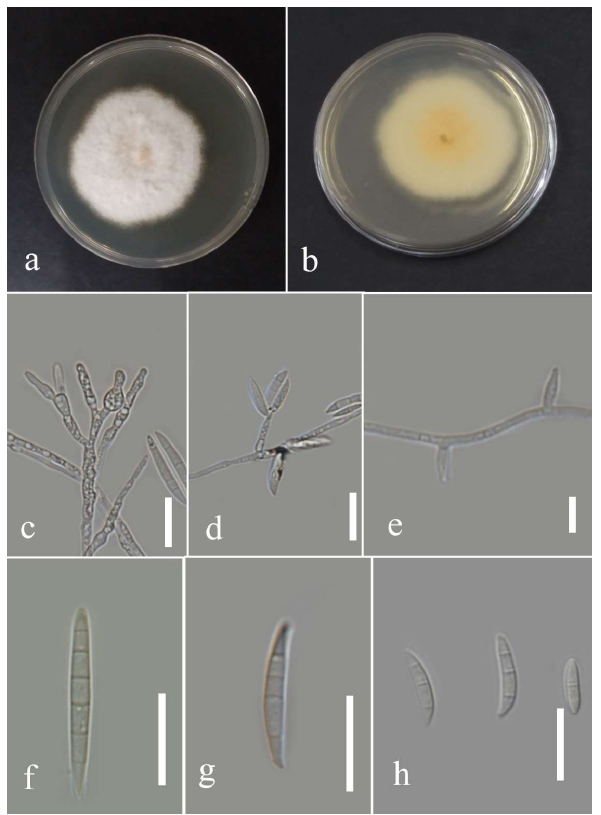
Figure 36. Morphology of Fusarium sulawesiense (MFLUCC 22-0163): ( a , b ) upper and reverse views of the colony after seven days of growth on PDA at 28 °C; ( c – e ) phialides; ( f – h ) conidia. Scale bars ( c , d , f – h ) = 20 µm and ( e ) = 10 µm.